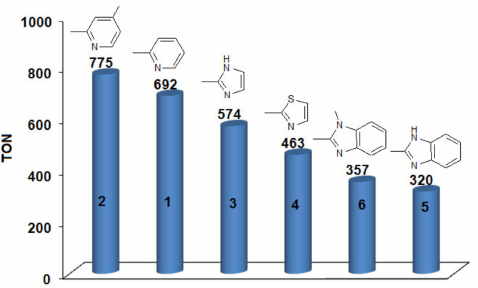
Figure 5. Comparison of the catalase-like activity of [Mn II (HL n )Cl 2 ] ( 1 – 6 , HL n = 1,3-bis(2’-Ar-imino)isoindoline, Ar = pyridyl (n = 1), 4-methylpyridyl (n = 2), imidazolyl (n = 3), thiazolyl (n = 4), benzimidazolyl (n = 5) and N -methylbenzimidazolyl (n = 6) complexes in bicarbonate